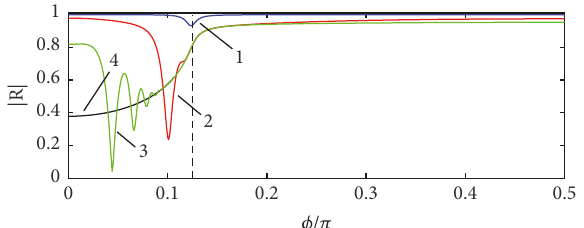
Figure 3: (Color online) the reflection coefficient at normal inci- denceasafunctionoftheangle 𝜙 (seetext).Thedashedlineindicates the specific angle 𝜙 = 𝜙 ∗ , at which the resonance cone generatrix is parallel to n . Lines 1, 2, and 3 correspond to the reflection from the uniform MM film (placed on the perfectly reflecting substrate) with the thickness 𝐿 (1) 𝑦 = 10 nm, 𝐿 (2) 𝑦 = 100 nm, and 𝐿 (3) 𝑦 = 1000 nm, and the line 4 corresponds to the reflection from the HM half-space. The wavelength of the radiation is 500